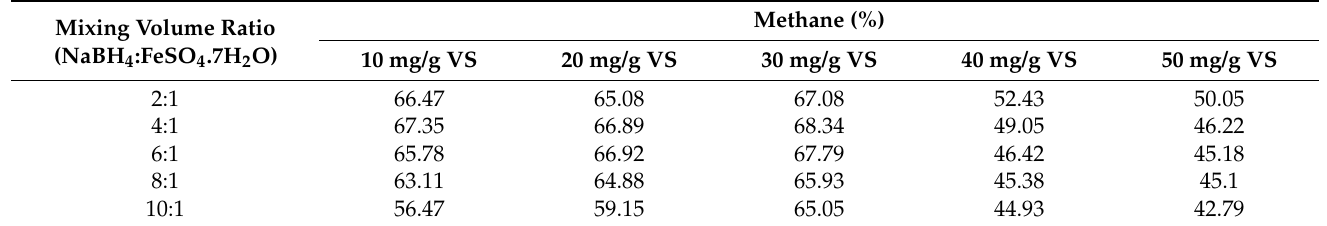
Table 5. Methane content of all BMP tests of substrates mixture of OMWW:CM with different doses of NP-ZVI and various MVR (the CH 4 content of the control test was